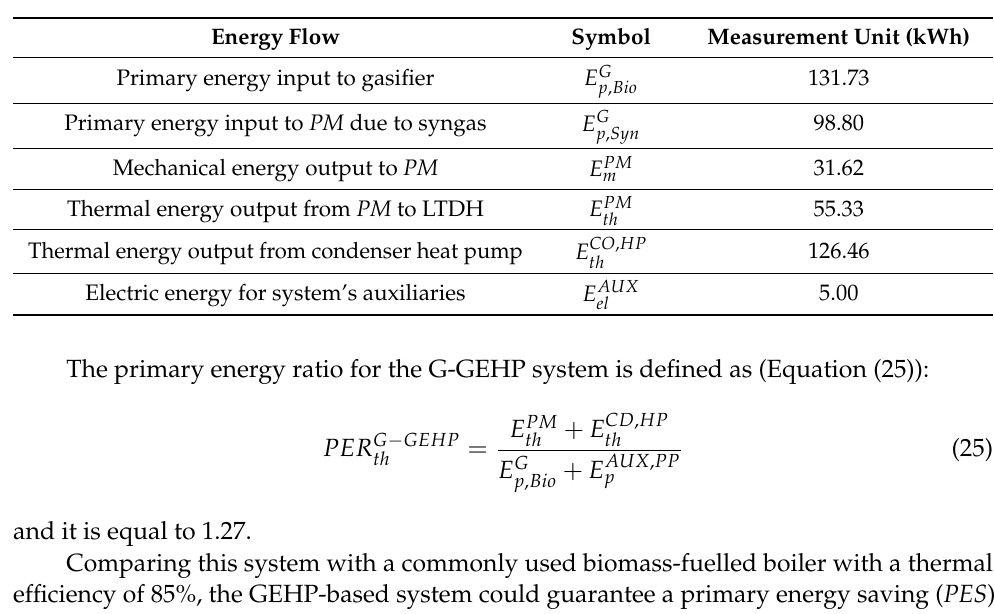
Figure 29. PES as a function of gasifier efficiency and heat pump COP.